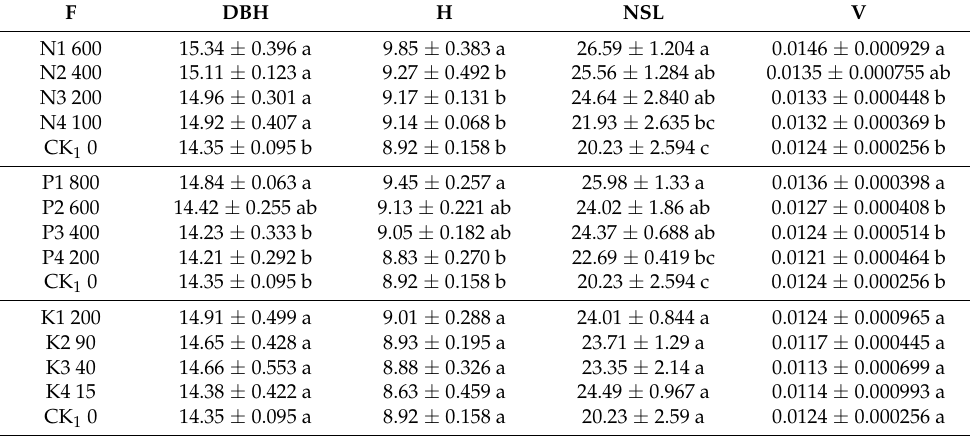
Table 2. Effects of two years in EXP.1 of N, P, and K fertilizer (F) on the diameter at breast height (DBH, cm), height (H, m), length of new shoots (NSL, cm), and trunk volume (V, m 3 ) of G. biloba in 2014 and 2015 in Yellow Sea Forest Park in China.